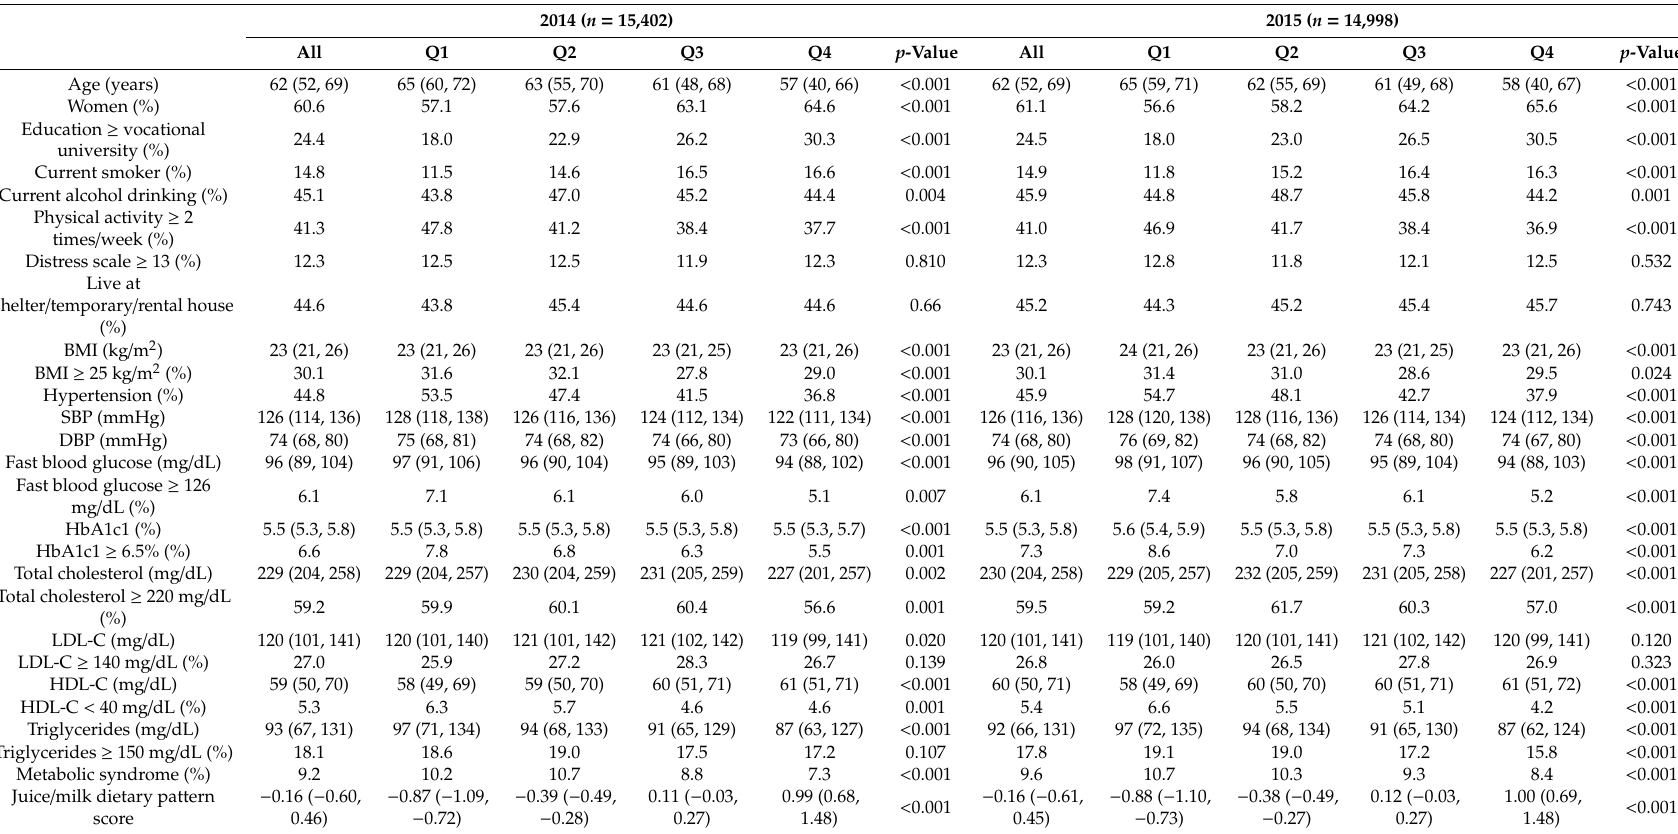
Table 3. Characteristics of participants (2011–2013) and their health checkup results (2014–2015) stratified by the cumulative means of meat dietary pattern